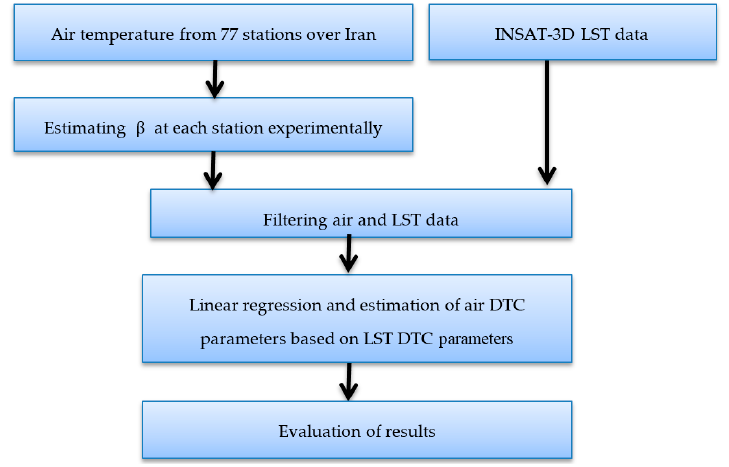
Figure 3. Flowchart of the proposed method to construct air DTC model from LST DTC parameters.